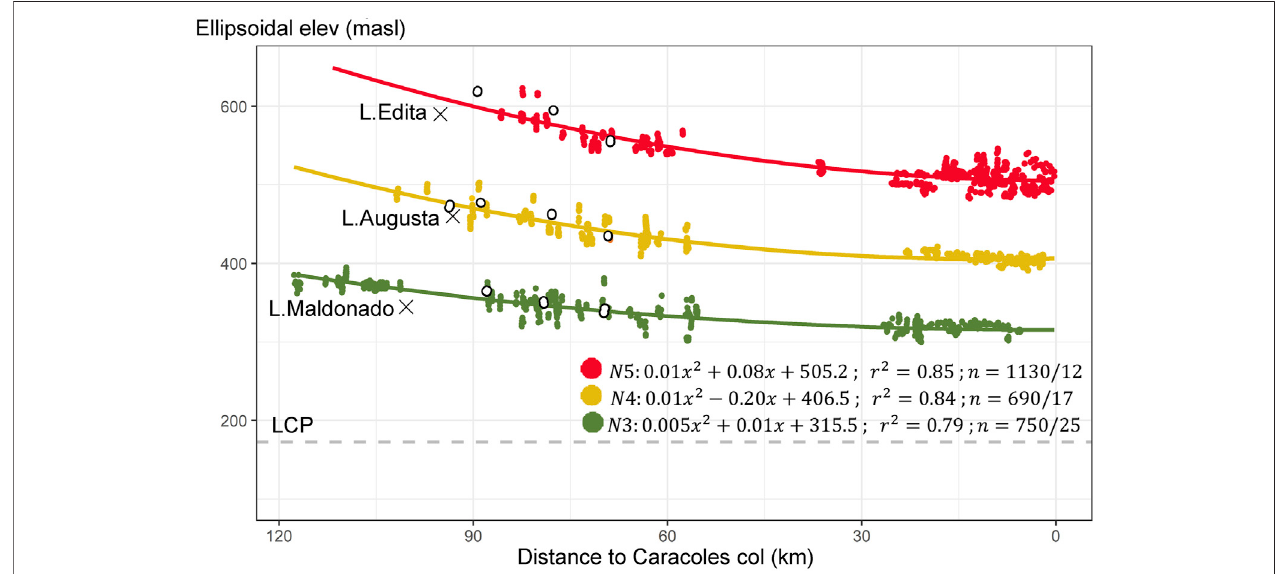
FIGURE 9 | Glacio-isostatic gradients along the fl owline of the former LCP glacier lobe. Polynomial regressions are shown with their equations, coef fi cients of determination, and the total number ofpoints used ( n (cid:1) DEM/GNSS). Differential GNSS data are shown as white circles. Elevations in this fi gure are ellipsoidal and in the text are referred in their orthometric conversion ( ∼ 20 m lower). Current elevation of LCP shown as dashed line for reference.